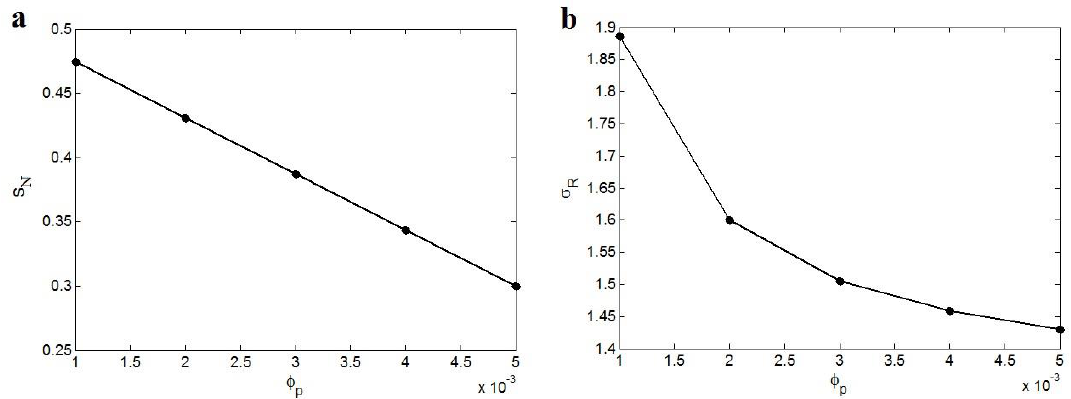
 ” on ( a ) “ S  = 0.02, σ Figure 6. The effects of “ Figure 6. The e ff ects of “ ϕ p ” on ( a ) “ S N ” and ( b ) “ σ R ” at ϕ f = 0.02, σ m = 40 MPa, R = 10 nm, t = 20 nm, N ” and ( b ) “ σ R ” at f m = 40 MPa, R = 10 nm, t = 20 nm, p N = 300 and σ i = σ N = 5000 N = 300 and σ i = σ N = 5000 MPa.